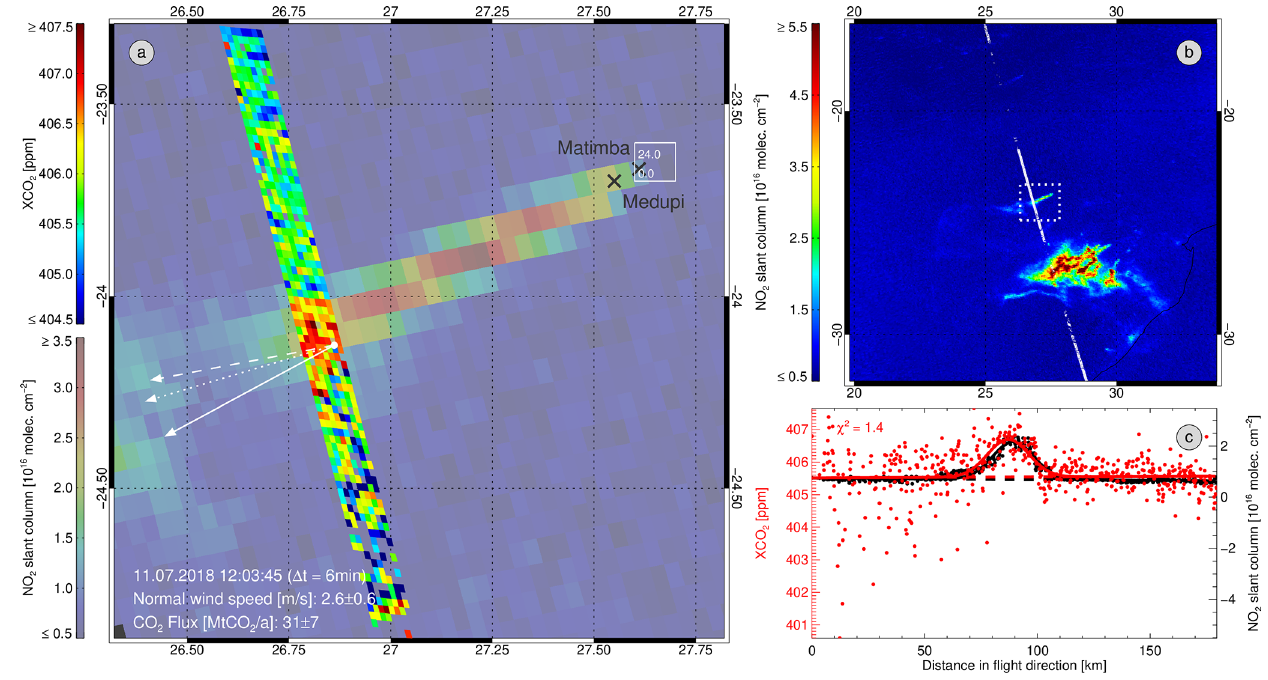
Figure 4. As in Fig. 1 but for the Medupi and Matimba power plants in South Africa on 11 July 2018.